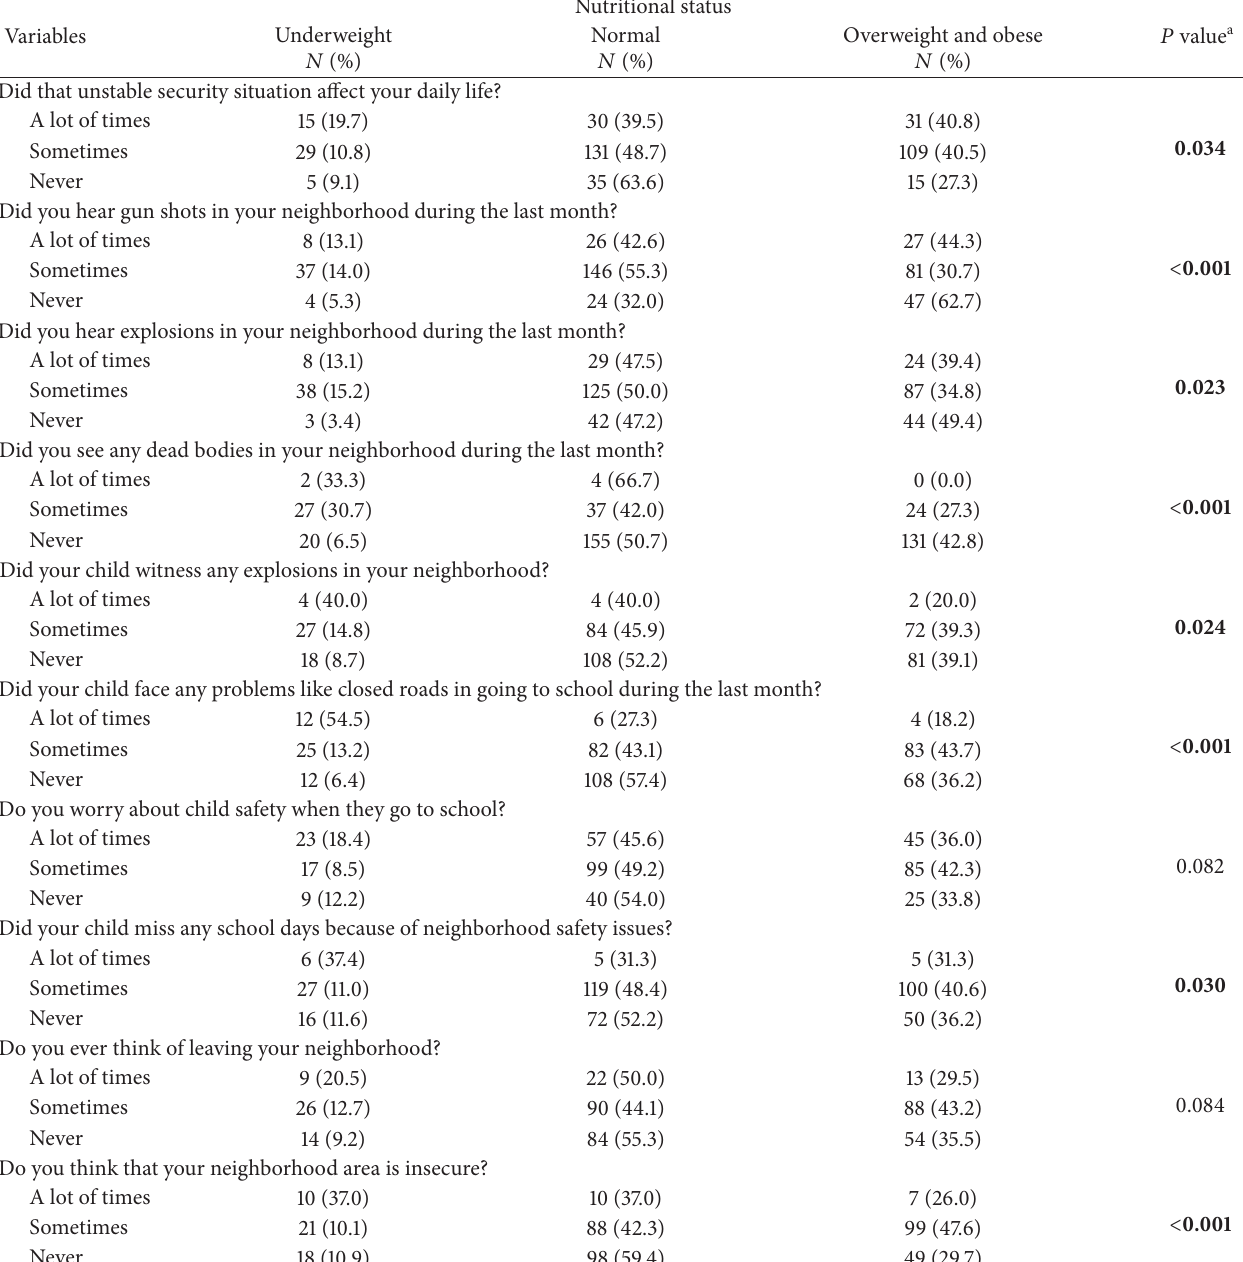
Table 2: Relationship between neighbourhood safety variables and children nutritional